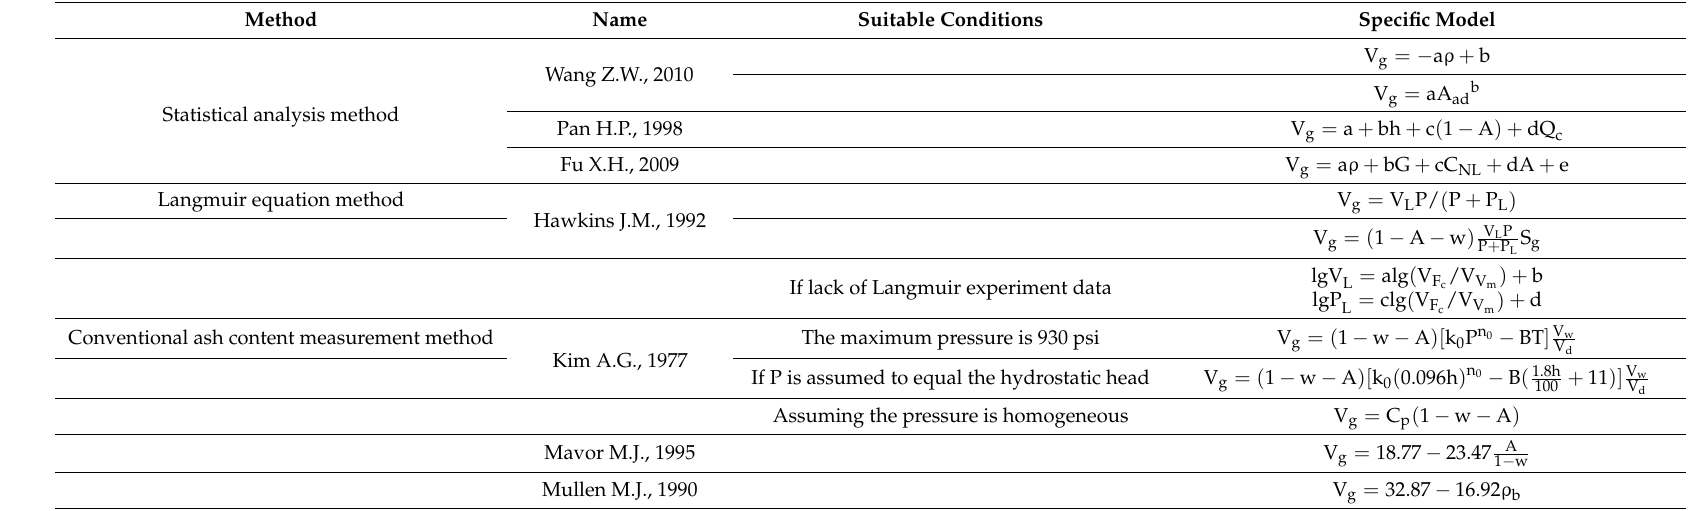
Table 1. Comprehensive table of the gas content